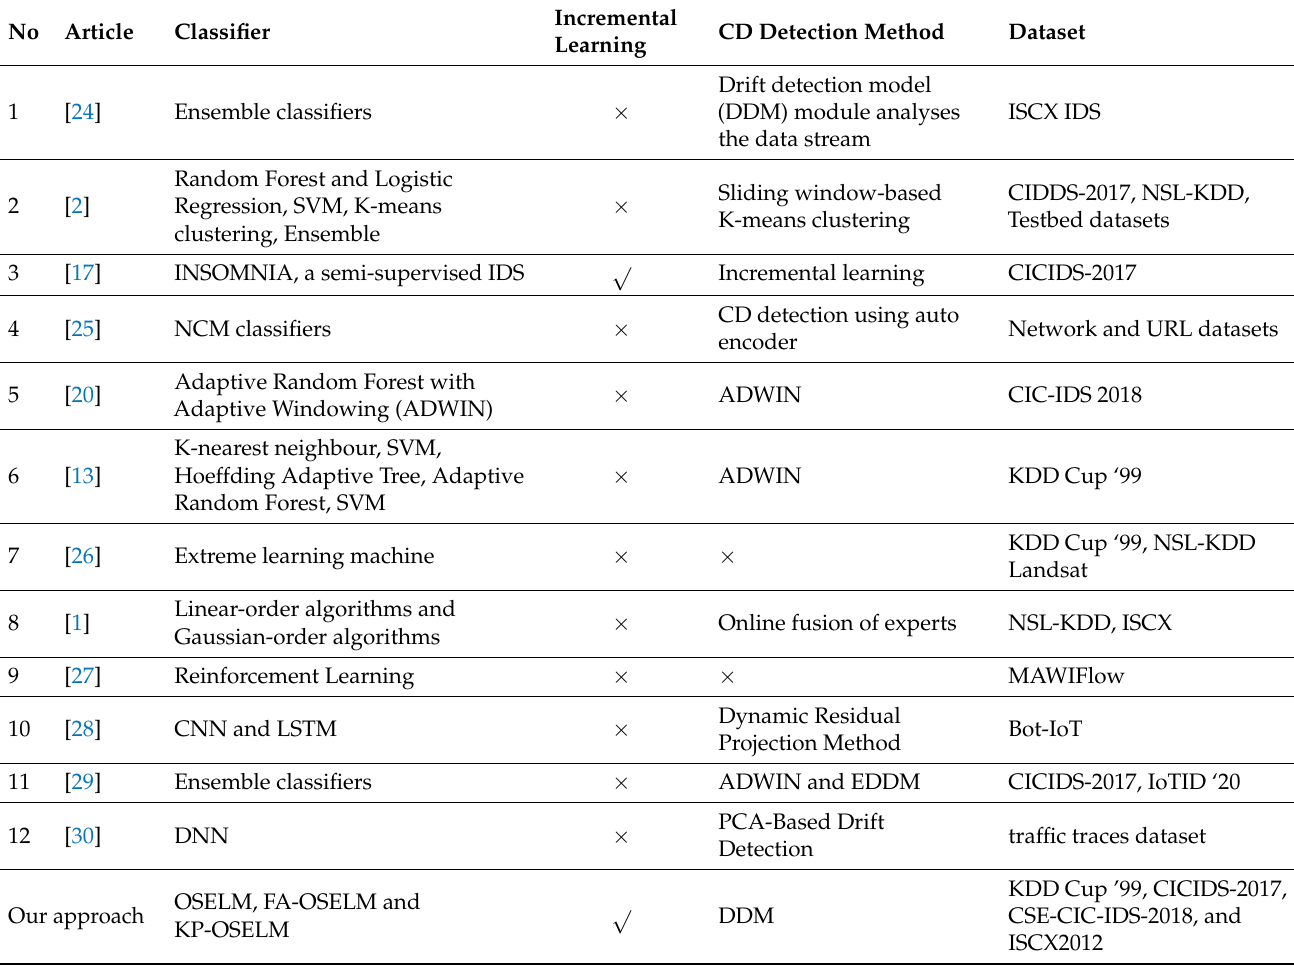
Table 1. Overview of existing models for data stream prediction with an awareness and handling of CD for IDS